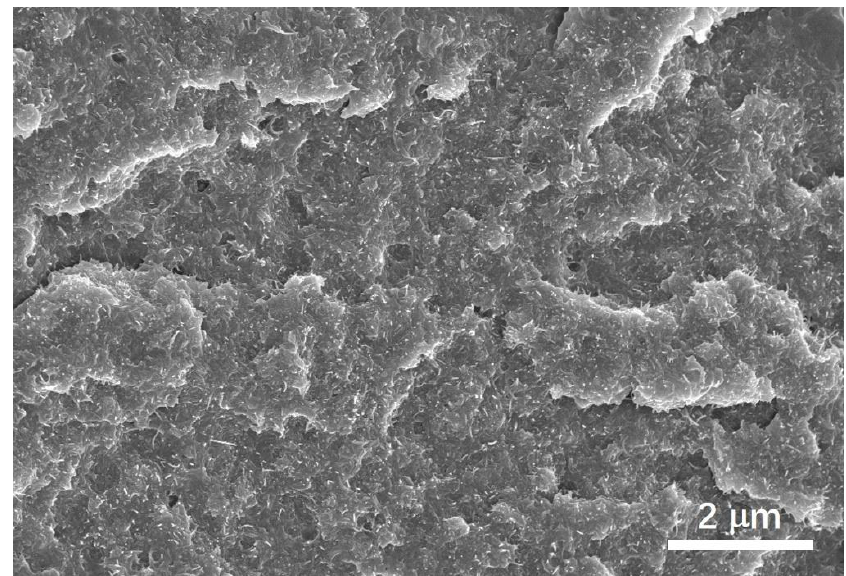
Figure 2. Field emission scanning electron microscope (FESEM) image for the cross-section of the multi-walled nanotubes (MWNT)/epoxy resin composite.